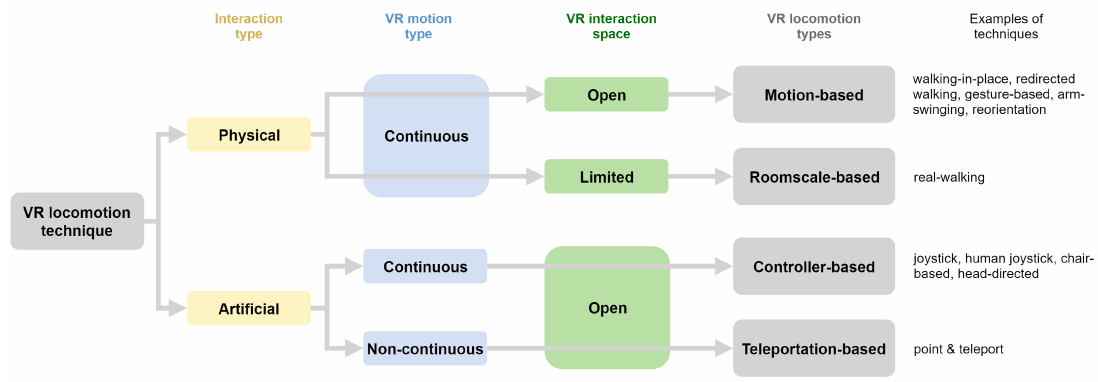
Figure 3. The VR locomotion